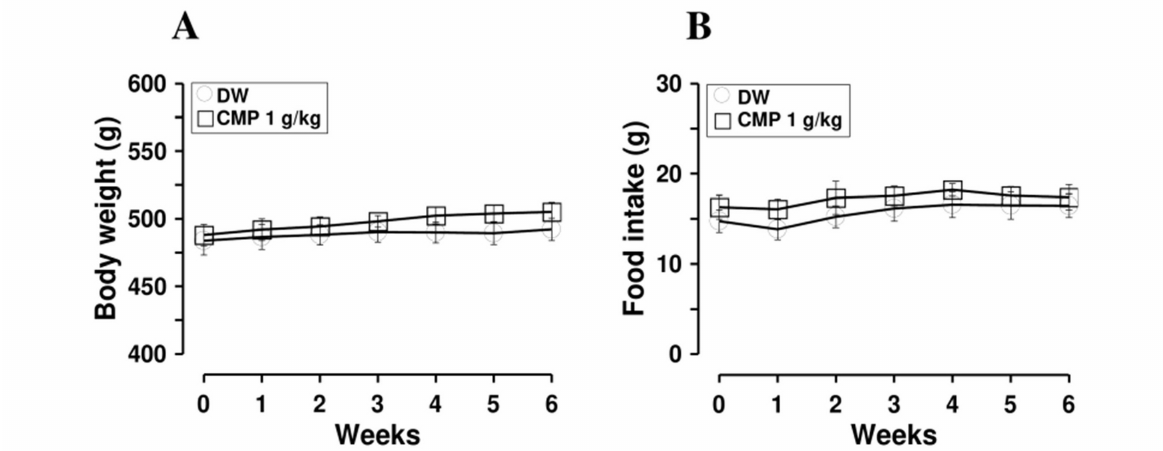
FIGURE 2 - Effects of CMP (1 g/kg) or distilled water (DW) consumption by the middle-aged male rats on body weight (left) and food intake (right). Each point represents mean ± SEM of 6 rats.